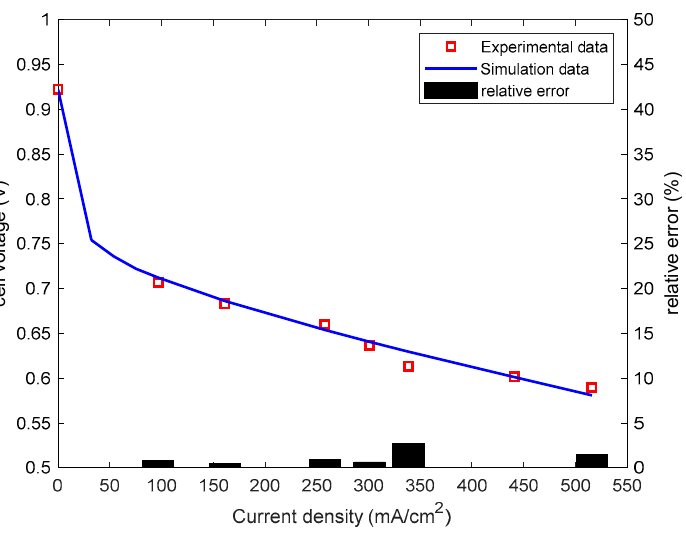
Figure 4. Polarization curve and error analysis